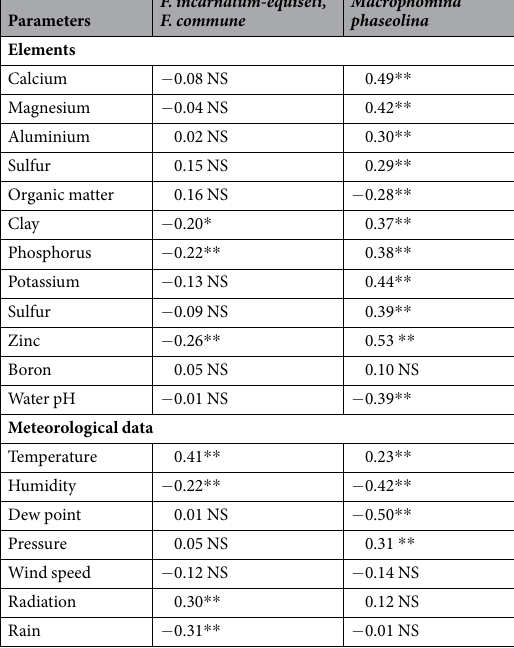
Table 1. Correlations between the frequency of isolation of Fusarium species and environmental parameters. Chemical analysis of the soil and weather data in Arroio Grande, Santa Maria, Rio Grande do Sul, Brazil. NS non-significant, * significant at 10% (P < 0.10), ** significant at 5% (P < 0.05) by Pearson correlation